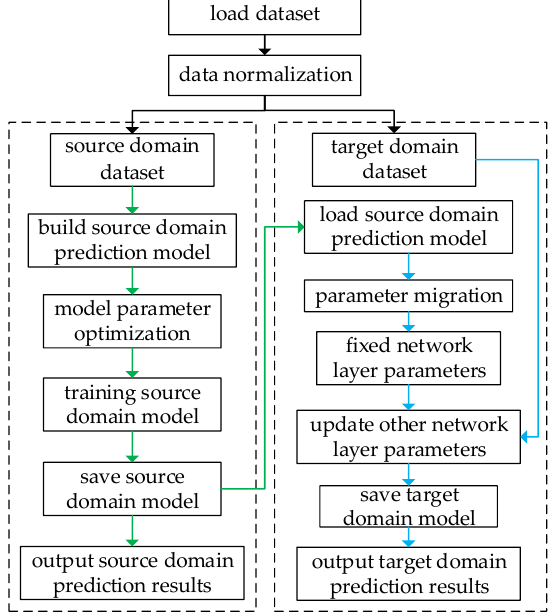
Figure 7. Bi-LSTM network incremental training flow chart.